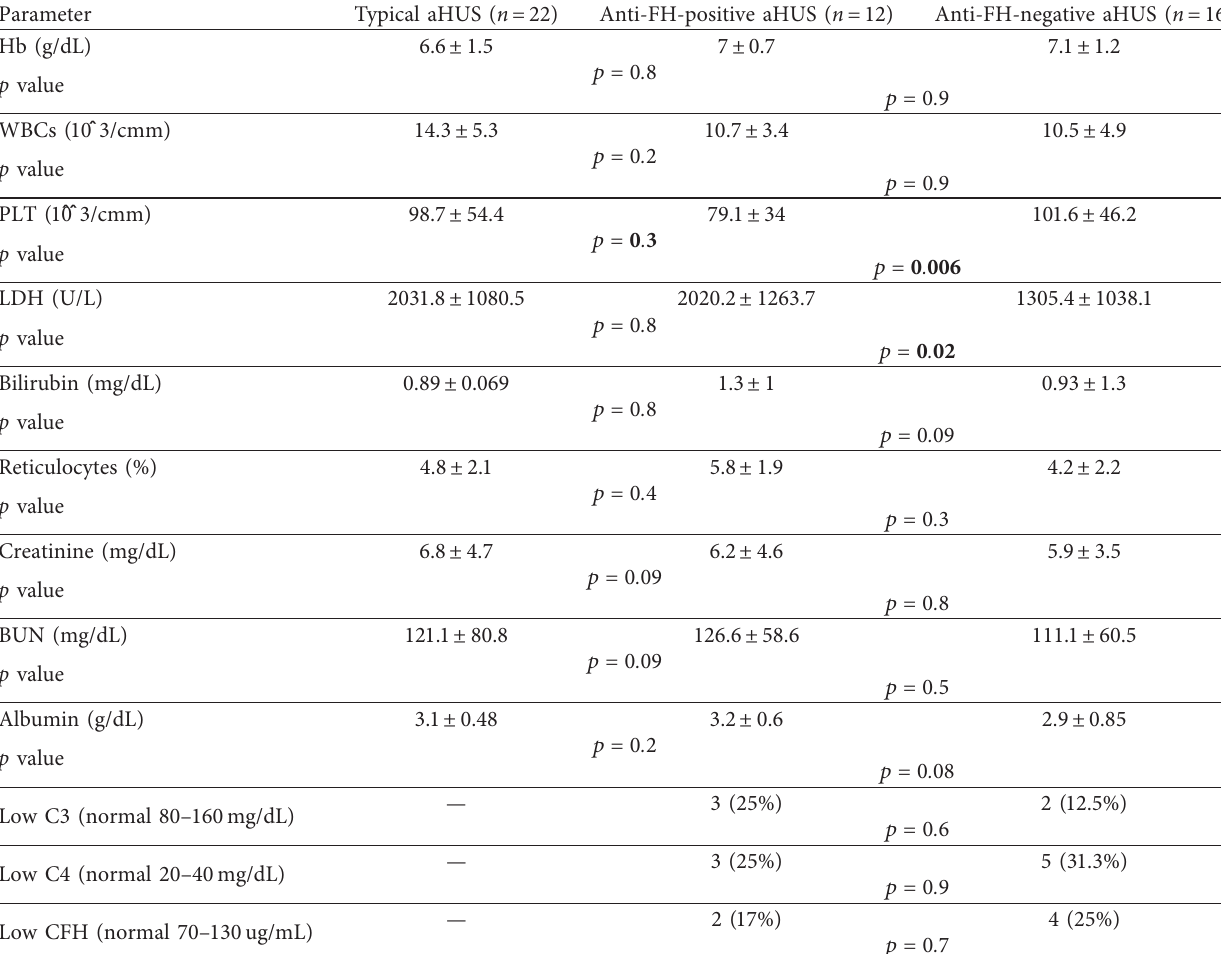
Table 2: Laboratory data of HUS